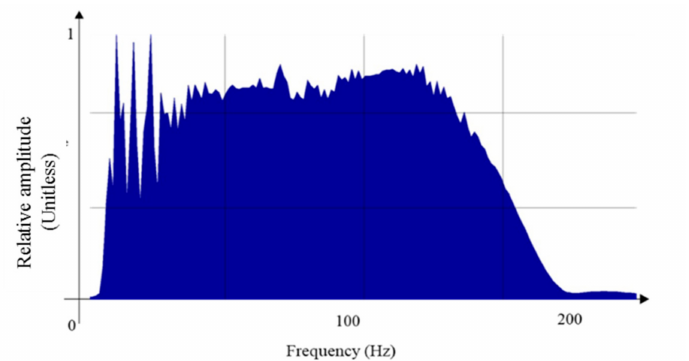
Figure 2. Amplitude spectrum of spectrally broadened data.